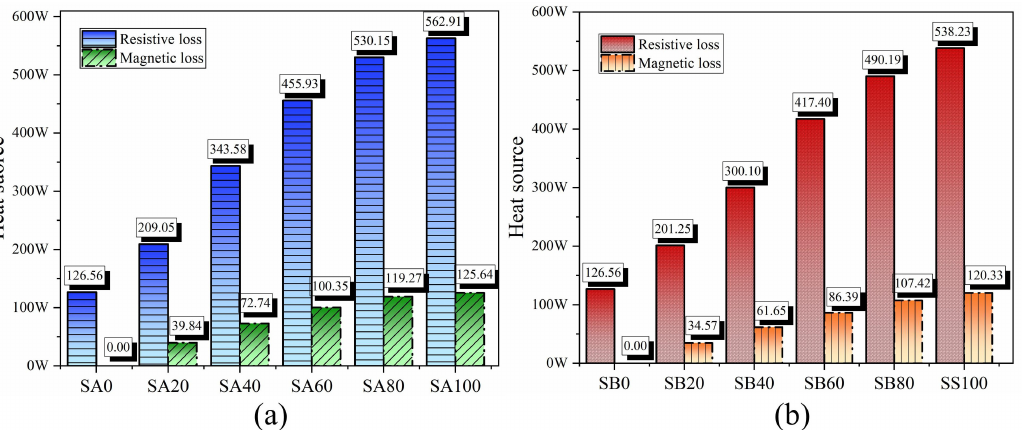
Figure 9. The heat source analysis of asphalt mixtures with different steel slag contents with SA ( a ) and SB ( b ). and SB ( b